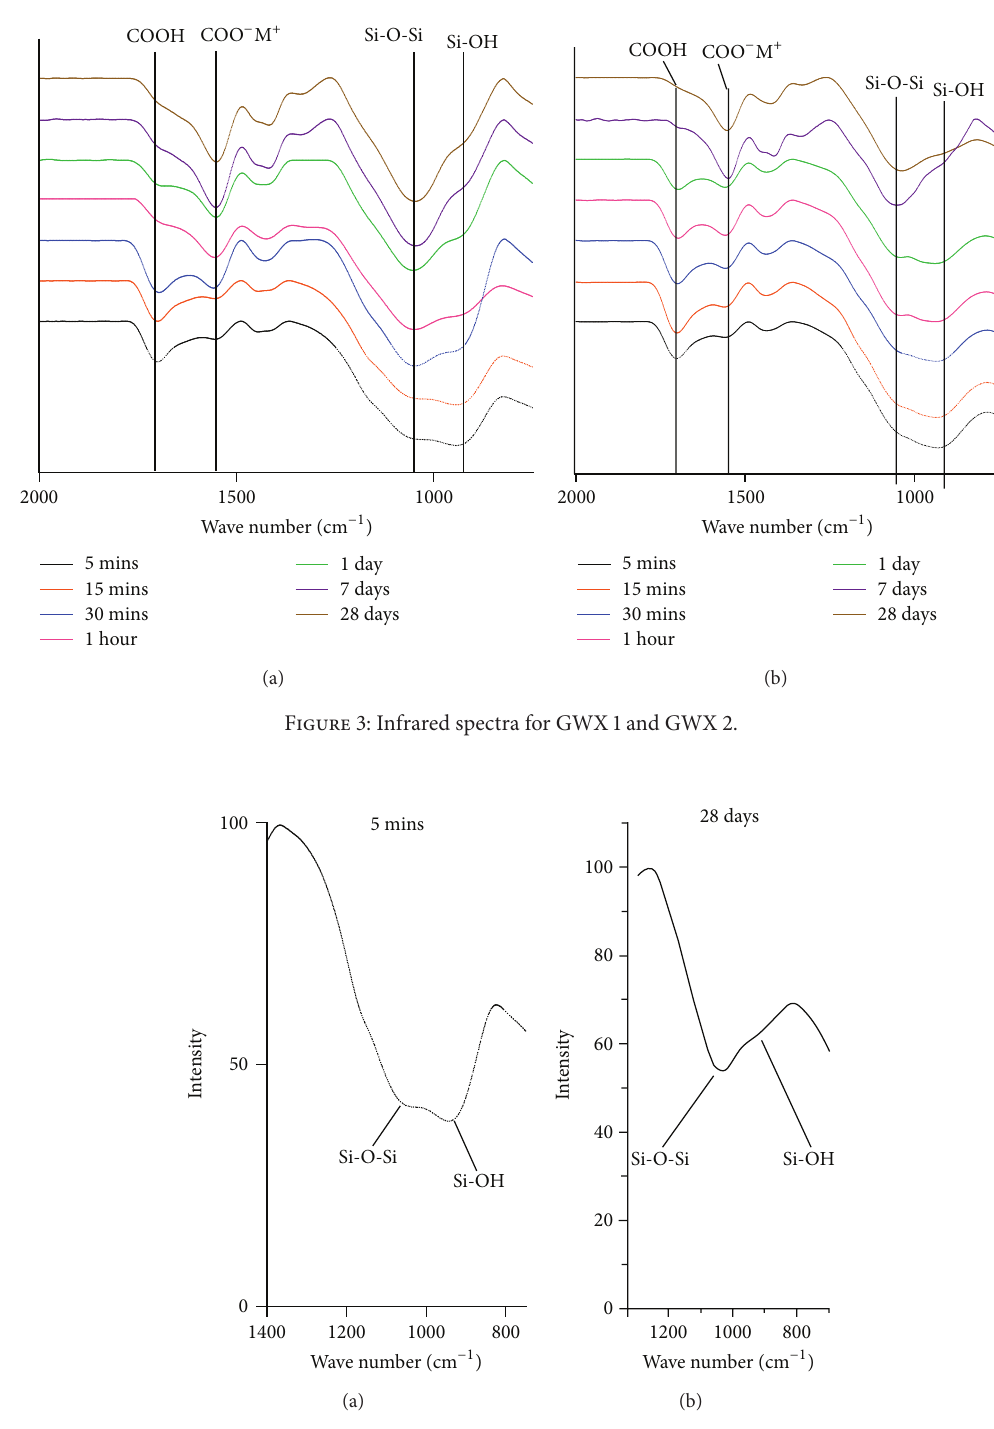
Figure 4: Infrared spectra of GWX 1 at 5 minutes and 28 days ageing